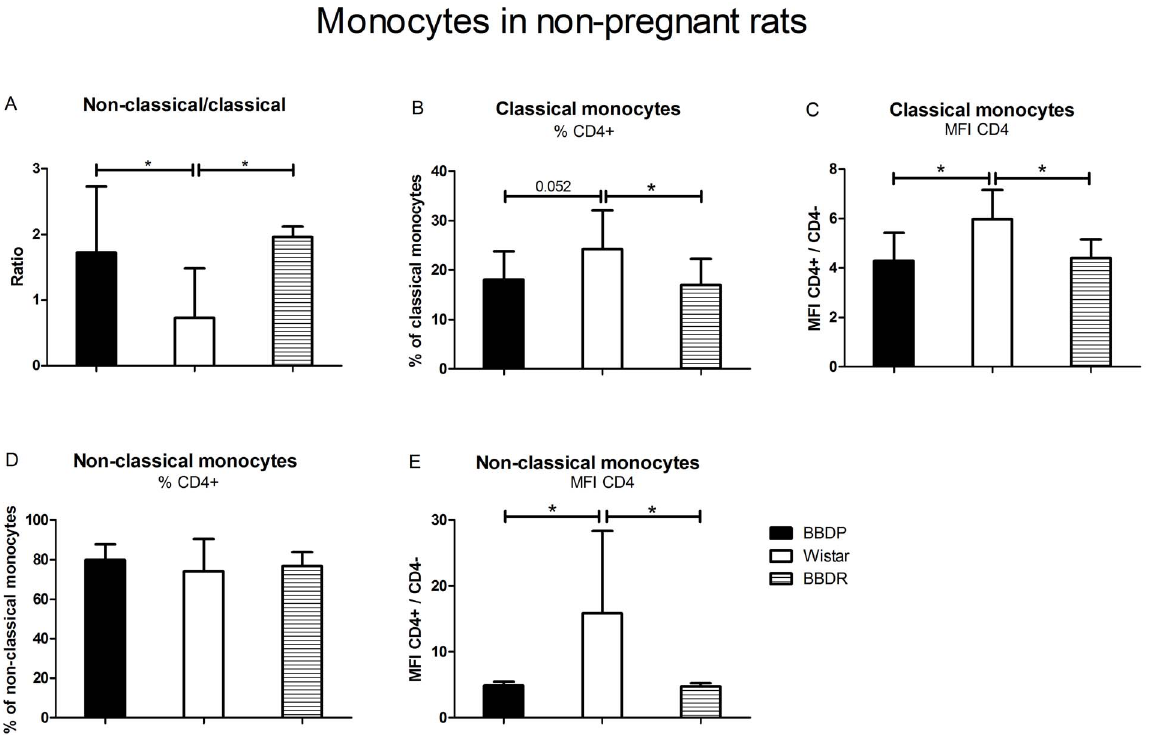
Figure 4. Monocyte subpopulations in non-pregnant rats. The ratio of non-classical/classical monocytes [A], the percentage of CD4 + classical monocytes [B], the MFI of CD4 on classical monocytes [C], the percentage of CD4 + non-classical monocytes [D] and the MFI of CD4 on non-classical monocytes [E] in non-pregnant animals of each strain. Values expressed as median with range (Q 1 –Q 3 ), ‘*’ significant difference, Mann-Whitney U-Test, p ,